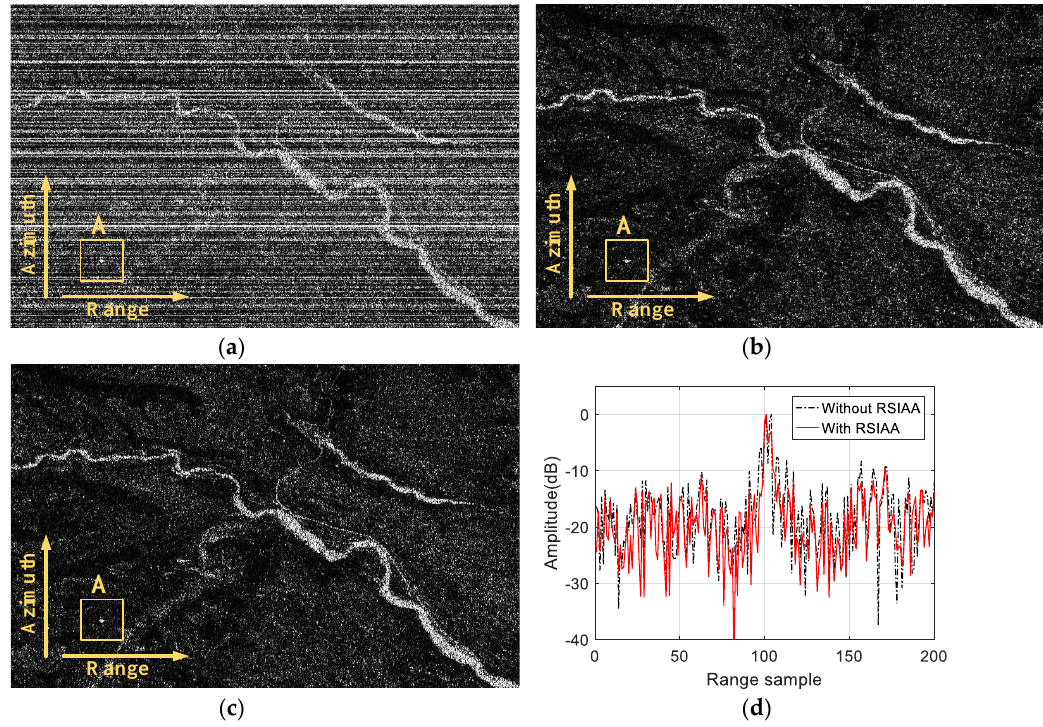
Figure 14. Imaging results of the first set of GF-3 SAR data . ( a ) The SAR image with RFI; ( b ) the SAR image without the RSIAA; ( c ) the SAR image with the RSIAA; ( d ) range profiles of the target in area A.